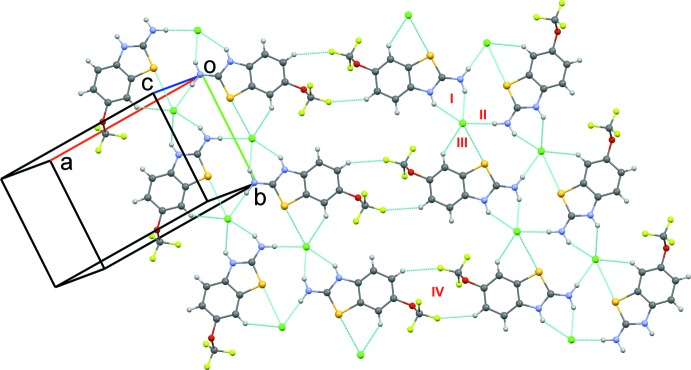
A comparative view of the packing of riluzolium chloride represented via N—H⋯Cl, C—H⋯Cl, C—H⋯F, and S⋯Cl inter­molecular inter­actions. Dotted pale-blue lines depict the inter­molecular inter­actions.